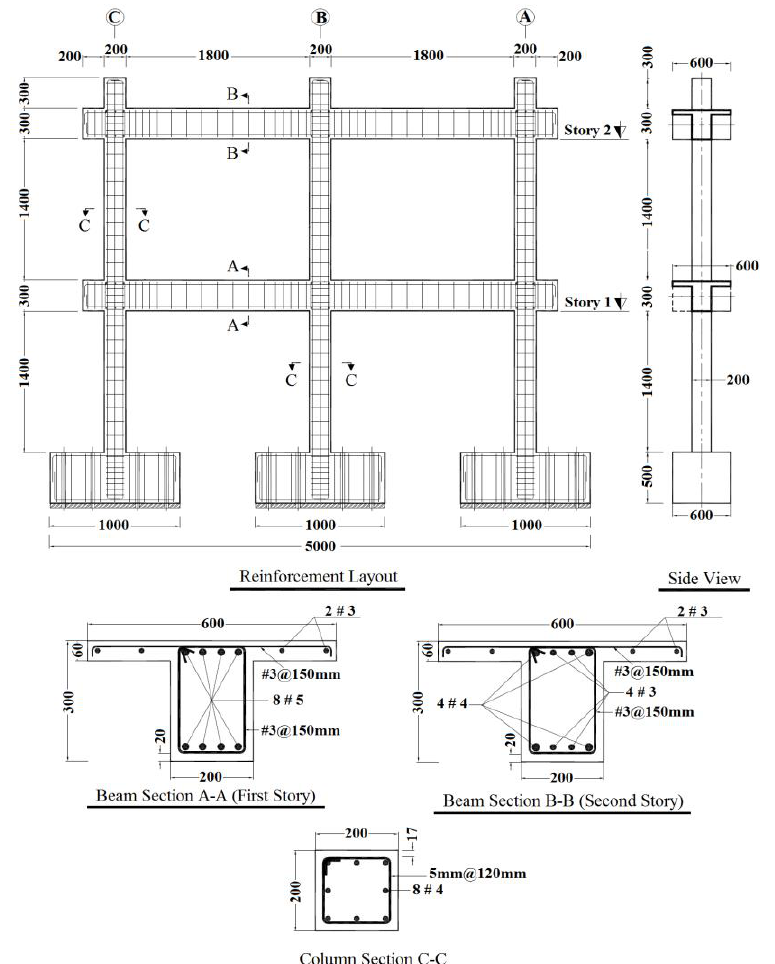
Fig. 1. Schematic scheme of the tested frame MUFS (Yavari et al., 2008)